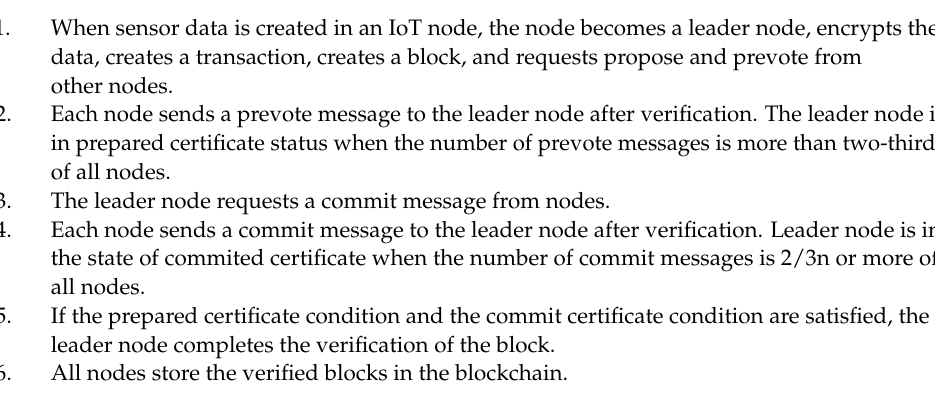
Algorithm 2. PBFT with block generator algorithm for Fusion Chain (n = the number of Fusion Chain